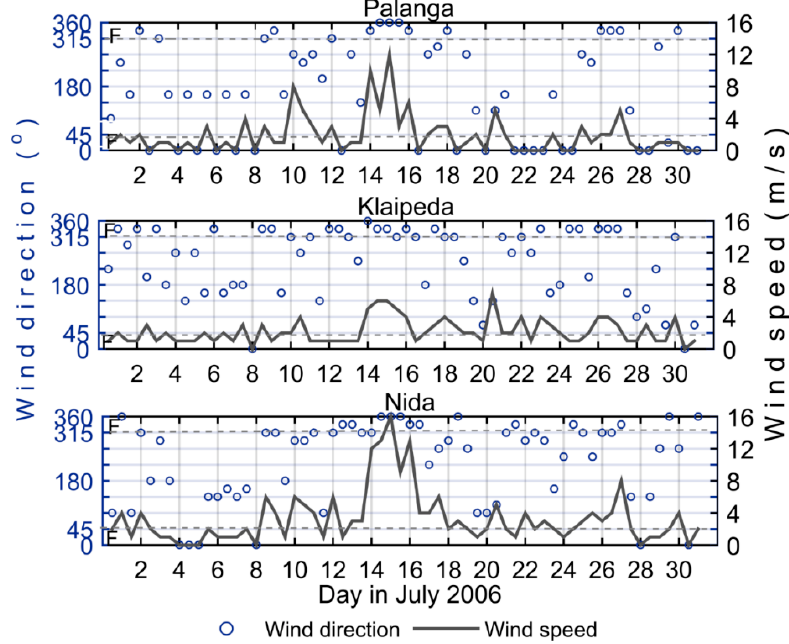
Figure 12. Wind speed and direction recorded in July 2006 at the Palanga, Klaipeda, and Nida coastal stations. F in the left corner of each of the panels indicates upwelling-favorable northerly winds.